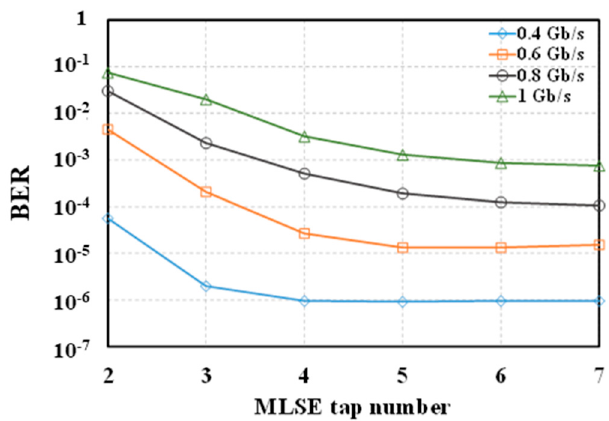
Figure 10. BER vs. MLSE tap number by transmitting 0.4, 0.6, 0.8, and 1 Gb/s Signal bitrate in harbor water of 10 m with transmit power of 24dBm and 30° FOV.